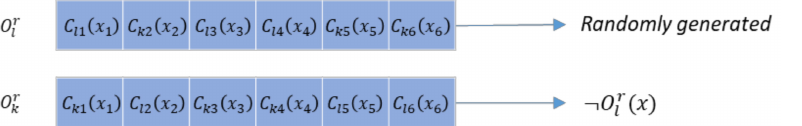
( x ) for the second child l